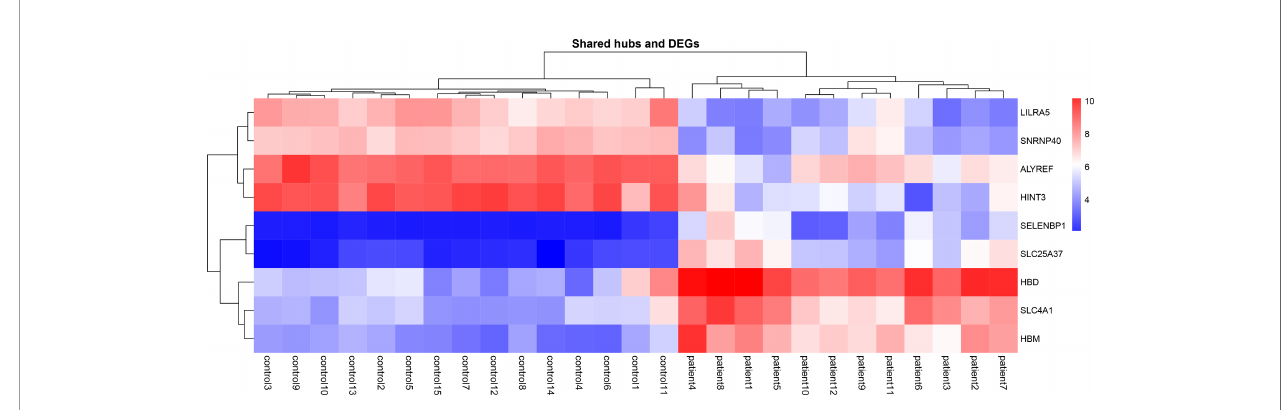
FIGURE 4 | Heatmaps of common gene expression related to the MS and healthy samples. The up-regulated and down-regulated genes are shown as a red and blue pallet,